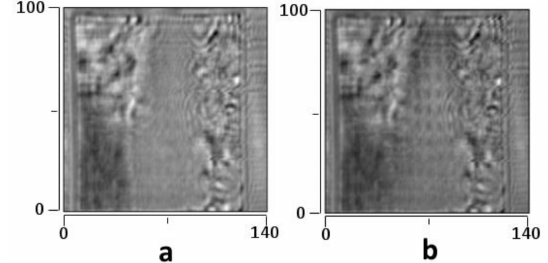
Figure 23. THz image of the dry mosaic mock-up ( a ) and image taken 60 min ( b ) after injection of 5 mL of water under the tiles in the top left corner. Size of the images: 140 × 100 mm 2 . Step size 1